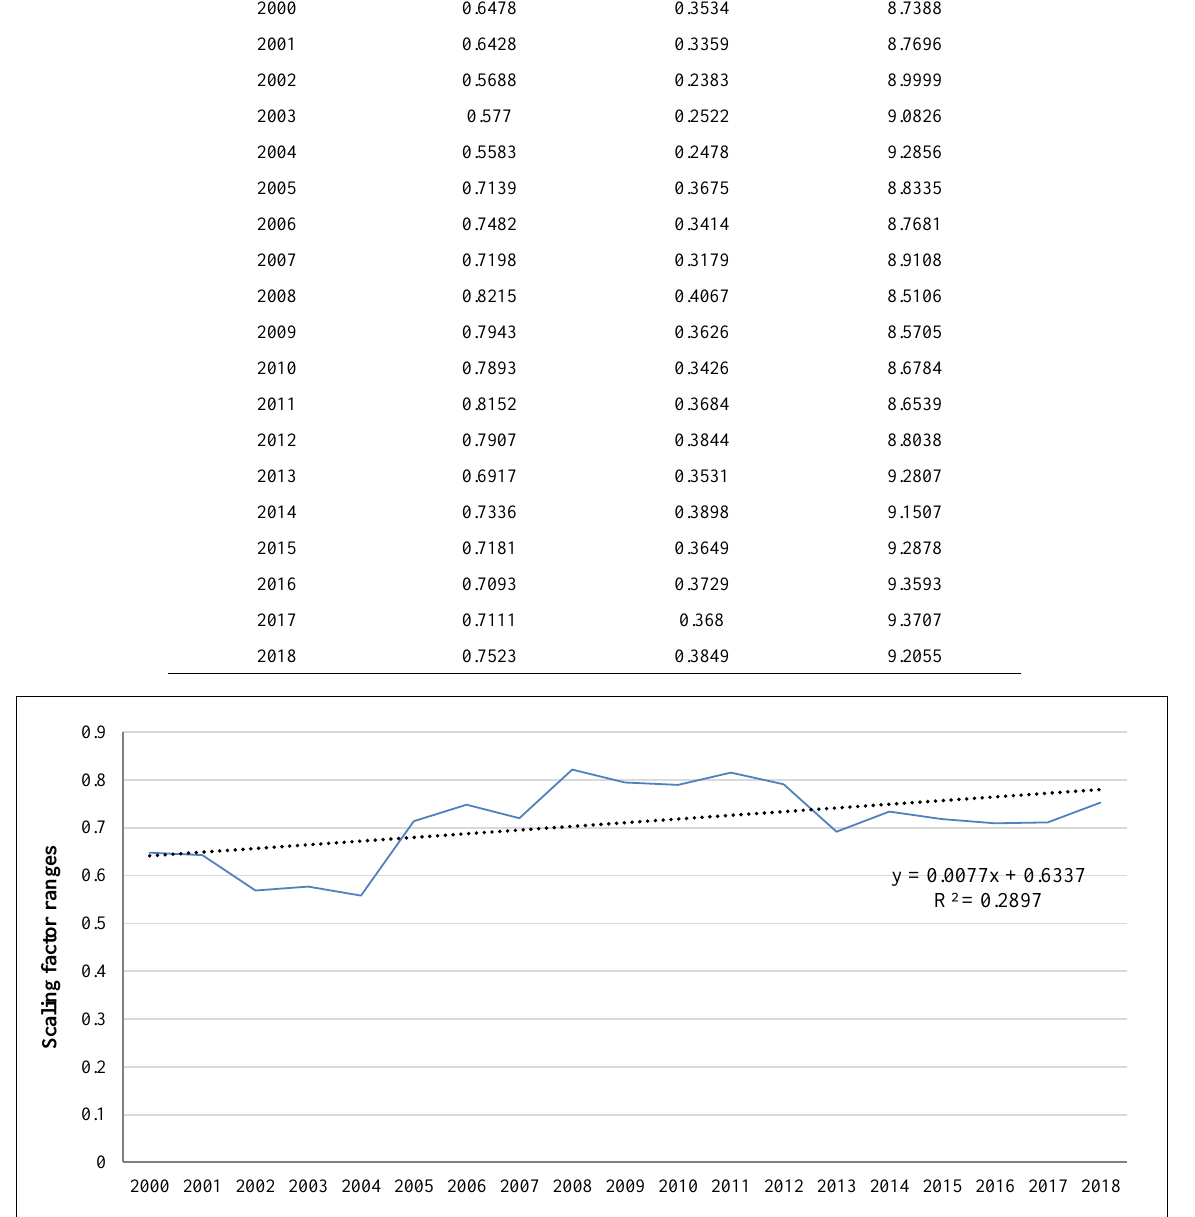
Figure 4. Scaling factor ranges for logarithms of GRP per capita and budget expenditures per